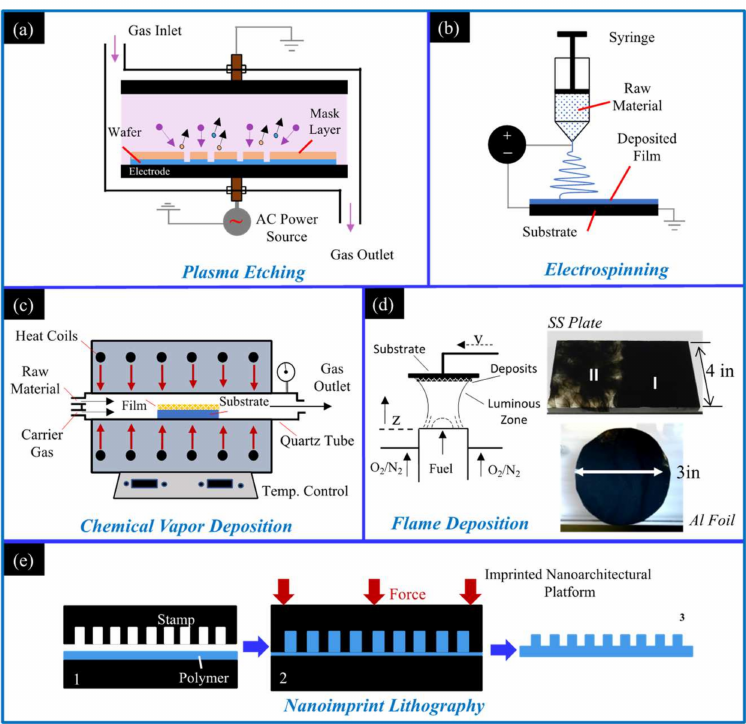
Figure 1. Schematics of available methods to create hydrophobic surfaces: ( a ) the plasma etching